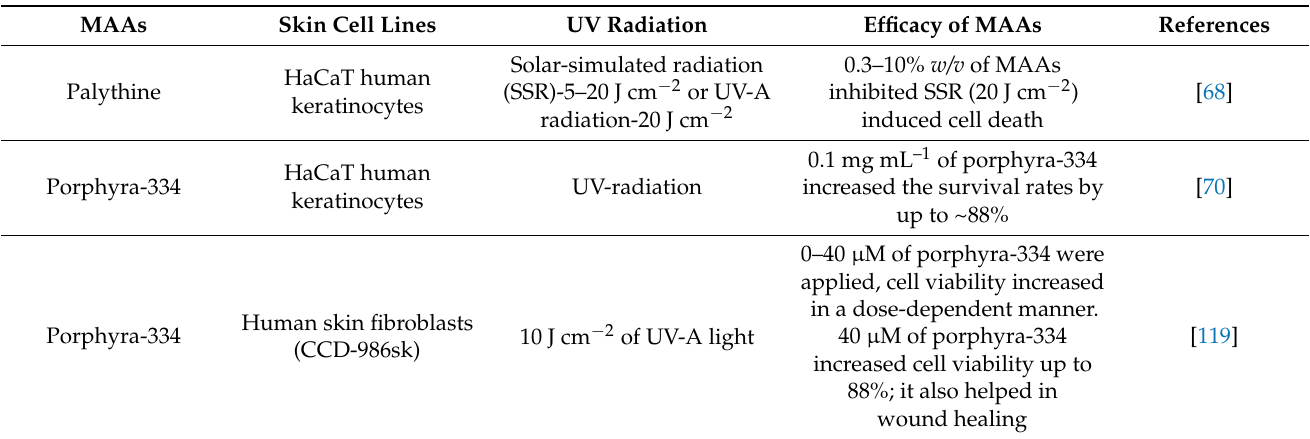
Table 2. In vitro efficacy of a few common MAAs against UV damage in skin